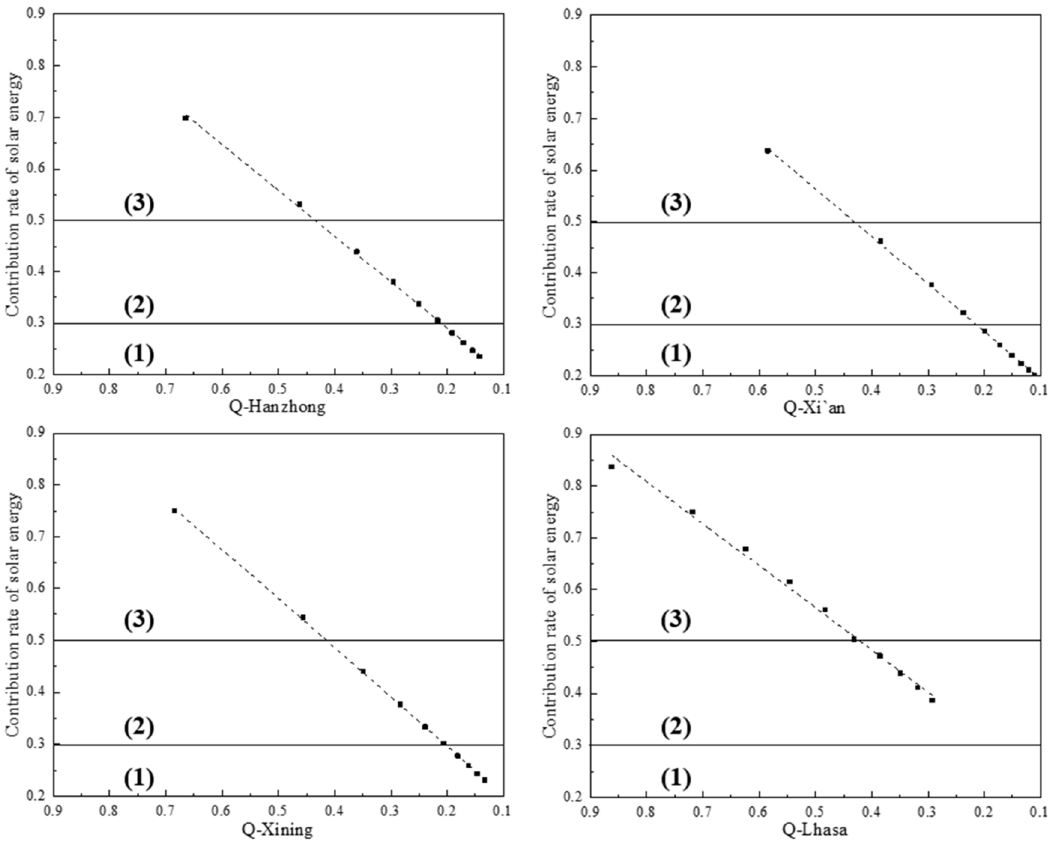
Figure 5. When Q is the independent variable, the solar energy contribution rate of office building in the four regions.